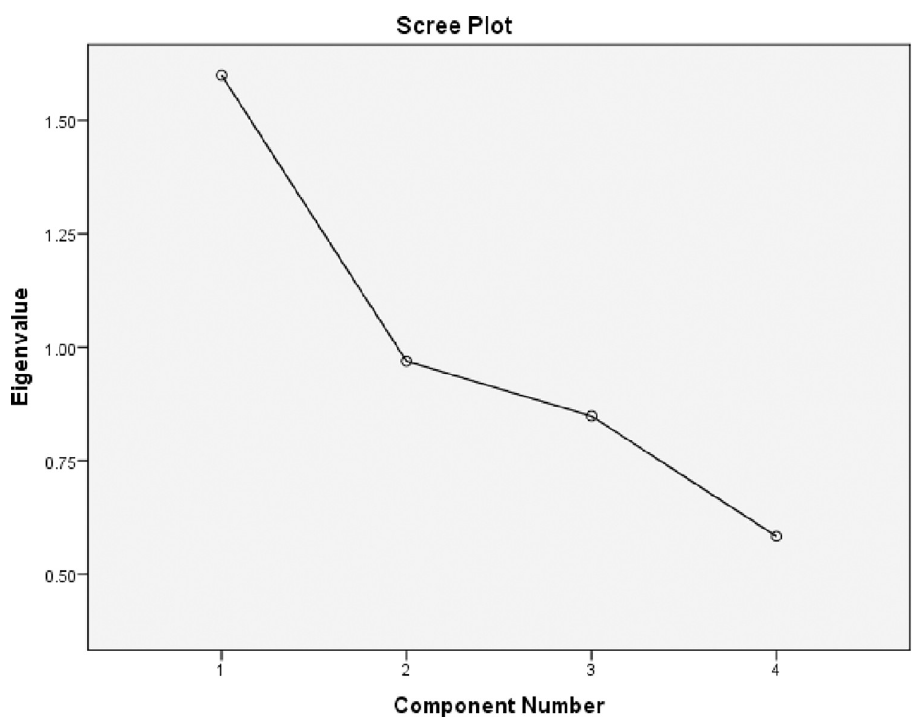
Fig 3. Scree plot the component number against eigenvalue (N = 201).